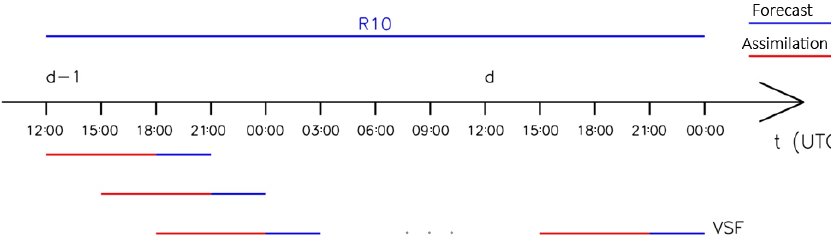
coverage over central Europe, and western Mediterranean (from 10 ◦ W to 35 ◦ E and from 30 to 60 ◦ N). The area of good coverage includes the region considered in this